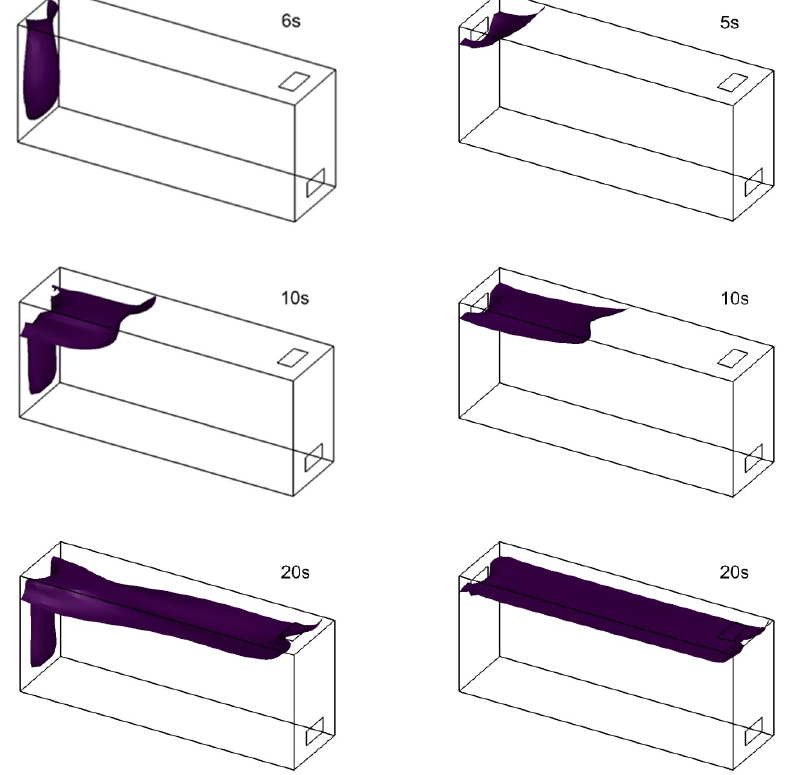
Figure 8. Iso-surface of 1% hydrogen mole fraction for Model 4 (left) and Model 5 (right).